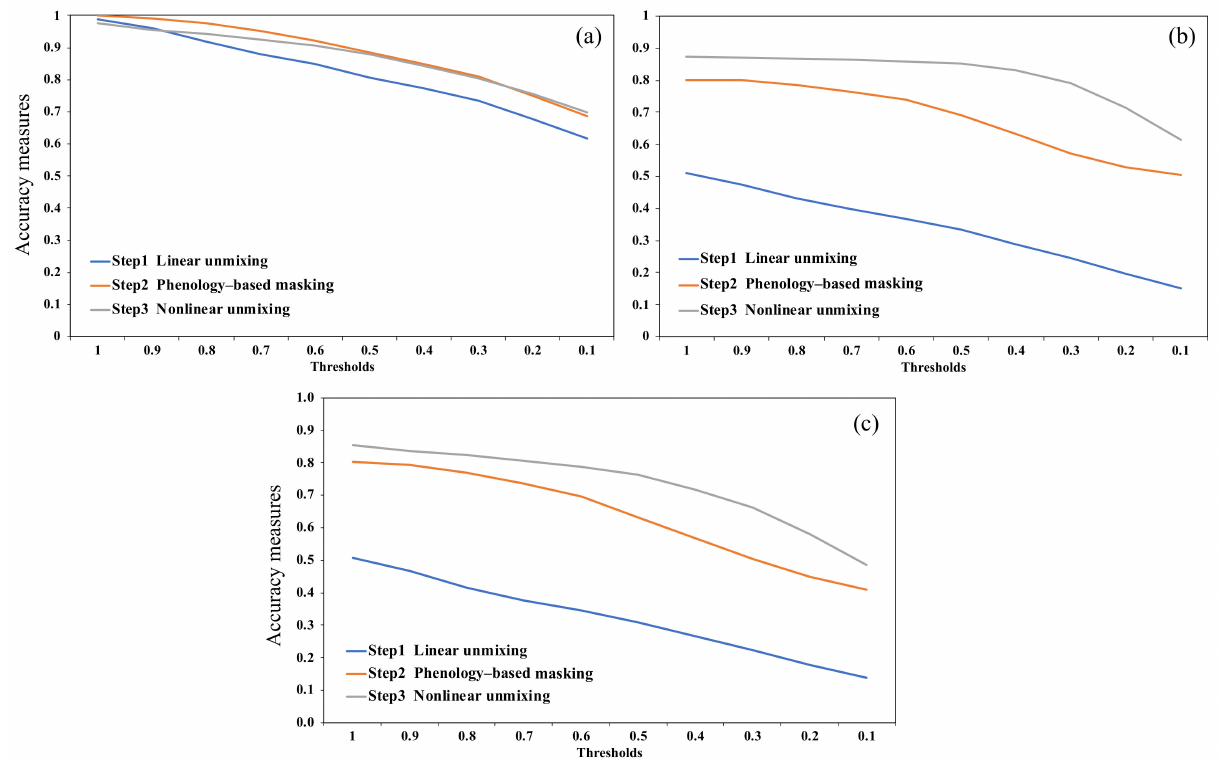
Figure 10. Classification performances for different thresholds over the three steps: ( a ) PA; ( b ) UA; ( c )